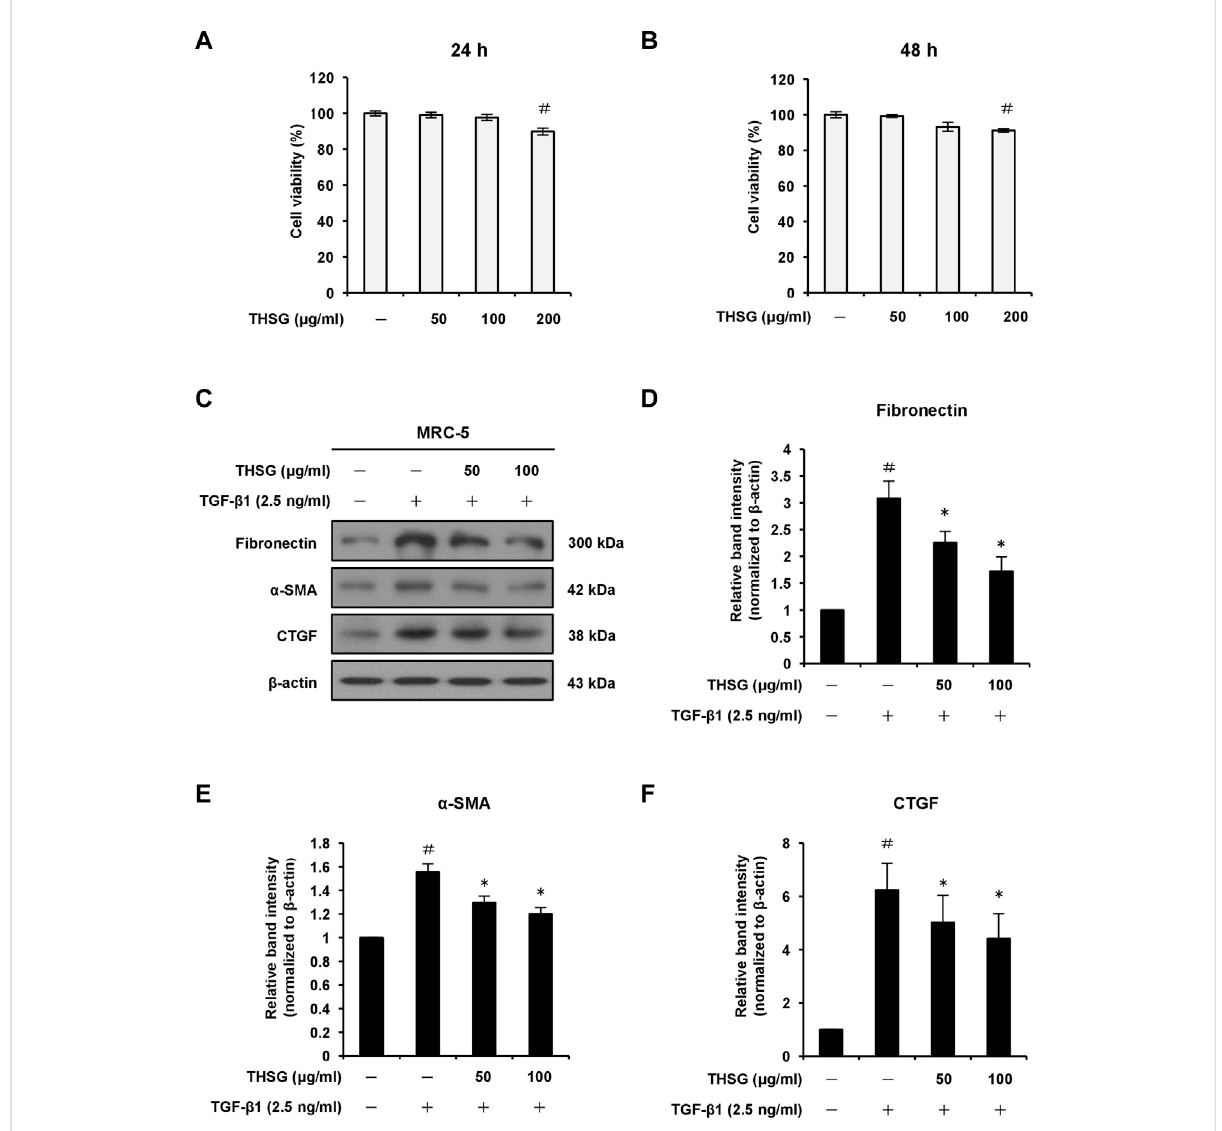
FIGURE 2 EffectofTHSGonproteinexpressionlevelsof fi bronectin, α -SMA,andCTGFinTGF- β 1-stimulatedMRC-5humanlung fi broblastcells.Thecells weretreatedwithdifferentconcentrations(50,100,and200 μ g/ml)ofTHSGfor (A) 24 hor (B) 48 handviabilitywasmeasuredbytheMTTassay. (C) Following 24 h of serum starvation, cells were treated with varying concentrations (50 and 100 μ g/ml) of THSG for 24 h, and then incubated with 2.5 ng/ml of TGF- β 1 for an additional 24 h. The protein expression levels of fi brotic markers in whole cell lysates were determined by Western blotting and the β -actin was used as a loading control. The relative protein levels of (D) fi bronectin, (E) α -SMA, and (F) CTGF were quanti fi ed by densitometry and normalized to β -actin. The results were expressed as relative units. Data are represented as the mean ± SEM of three independent experiments. # p < 0.05 compared with untreated group. * p < 0.05 compared with TGF- β 1-treated